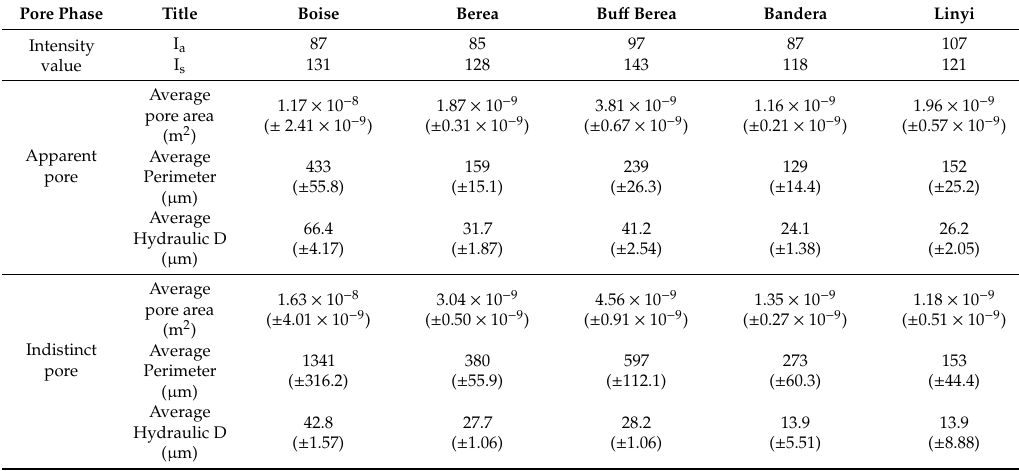
Table 2. Intensity values of the ternary segmentation and pore geometry data derived from image processing for characterization of apparent and indistinct